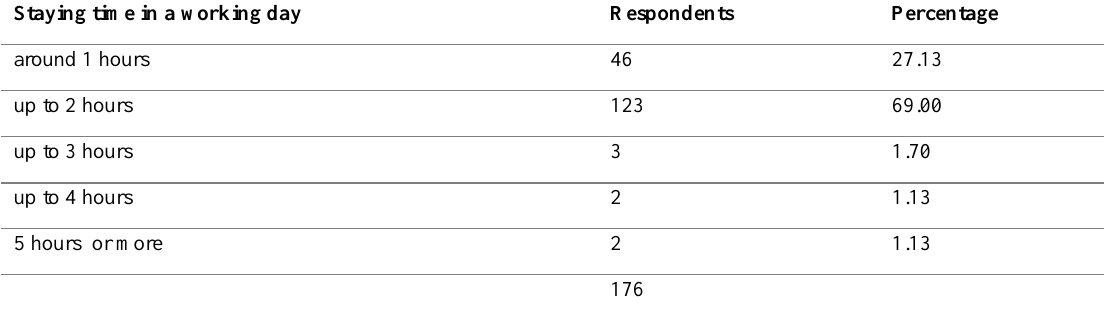
Table 5 : Teachers’ staying time in the colleges